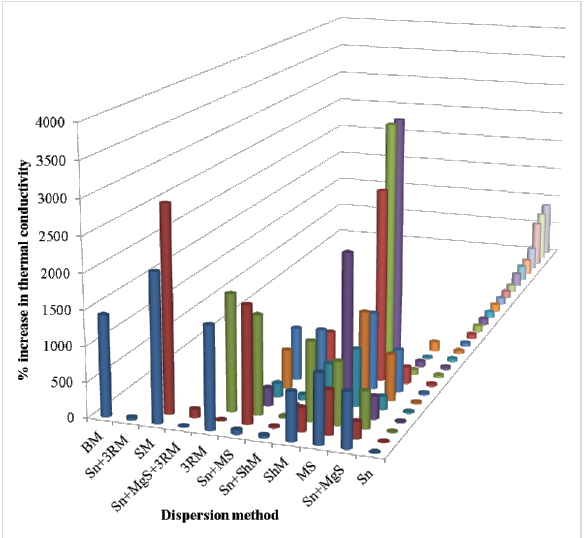
Figure 20: Increase in thermal conductivity as a function of the disper- sion method